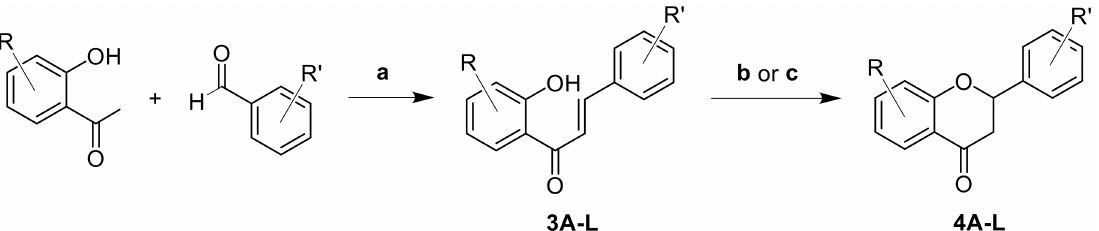
Figure 2. Synthesis of chalcone ( 3A – 3L ) and flavanone ( 4A – 4L ) derivatives. Reaction conditions: ( a ) excess of NaOH in 25 mL of MeOH; ( b ) basic activation: 5 eq NaOAc in MeOH (20 mL) under reflux; ( c ) photochemical method: in EtOH at 419 nM, 30 ◦ C for 7 days.